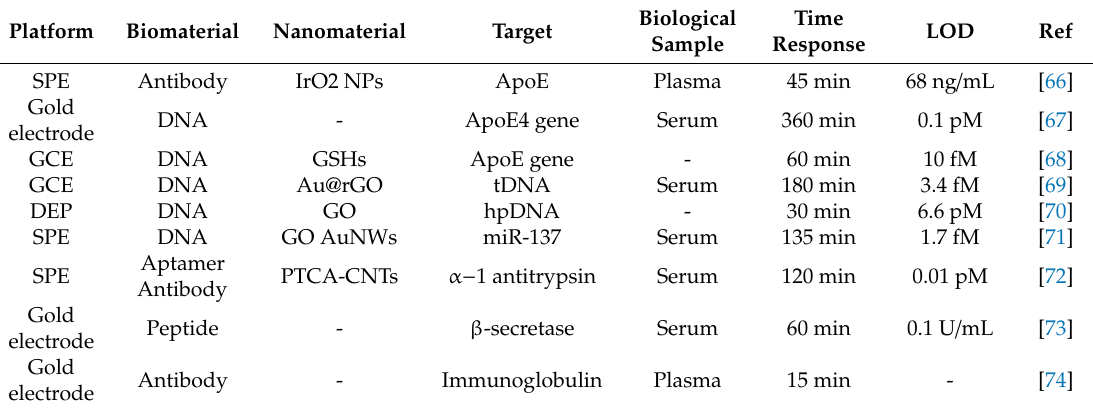
Table 2. Summary of the nanomaterial-based electrochemical sensors of non-A β -Tau biomarkers.